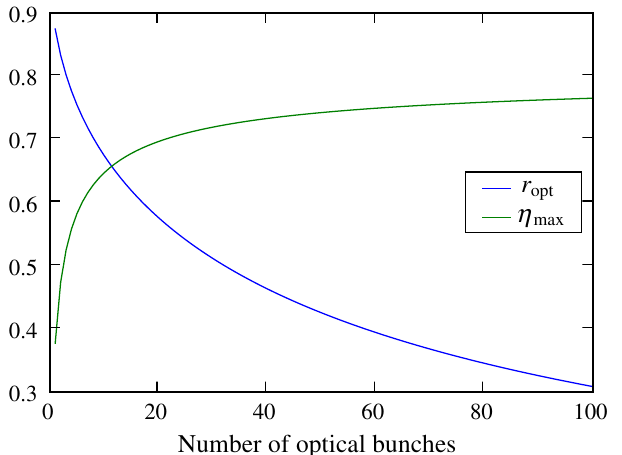
FIG. 7. The average initial gradient and induced energy spread as a function of the number of optical